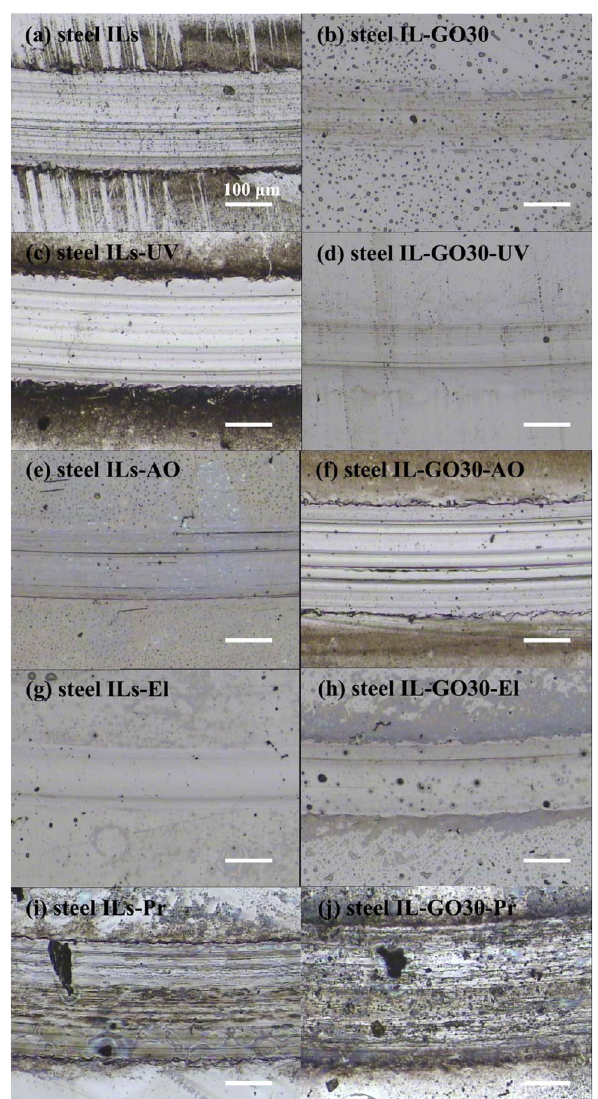
Figure 3. Optical micrographs of the wear scars of steel films before and after irradiations.